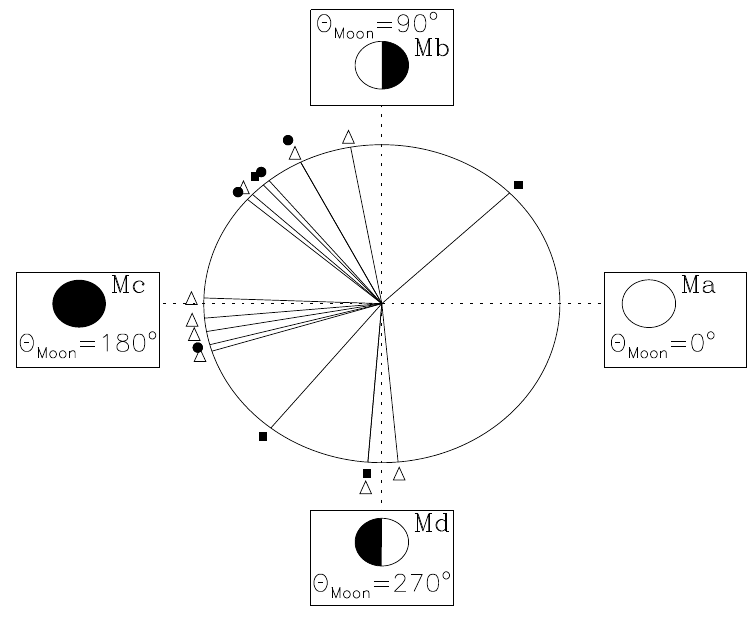
Figure 4. Θ Moon of the unlucky time points of Table 4. Notations as in Figure